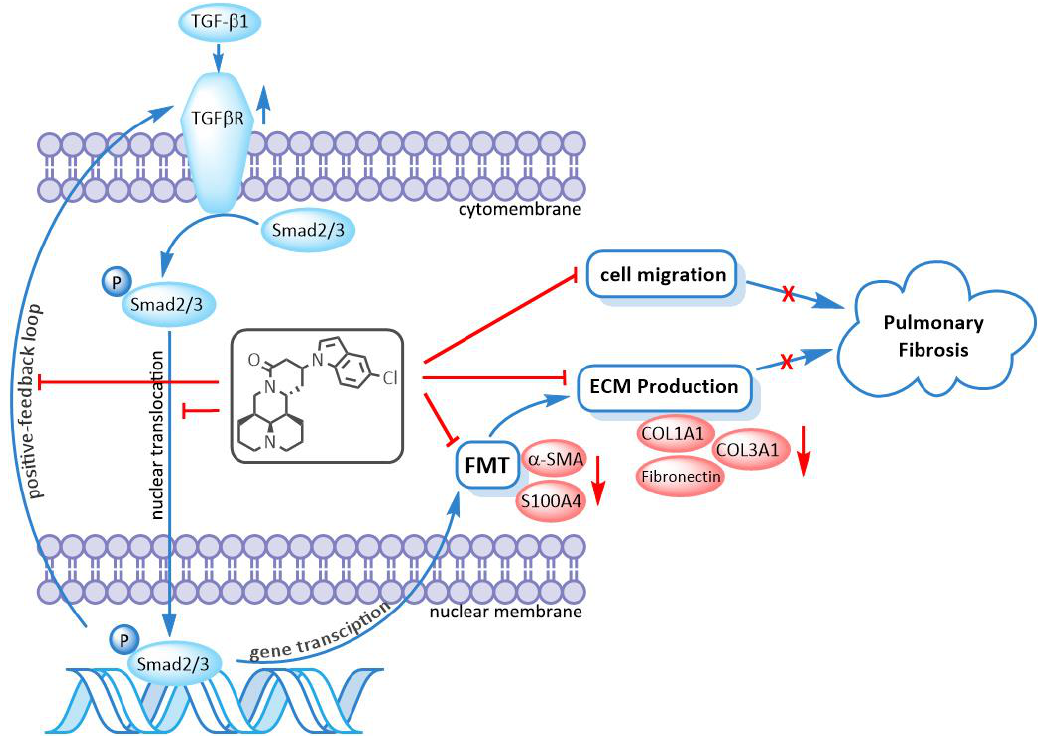
Figure 8. Compound 3f exerted anti-pulmonary fibrosis activity via repression of the TGF β /Smad signaling pathway. FMT is abbreviation for fibroblast-to-myofibroblast transition.